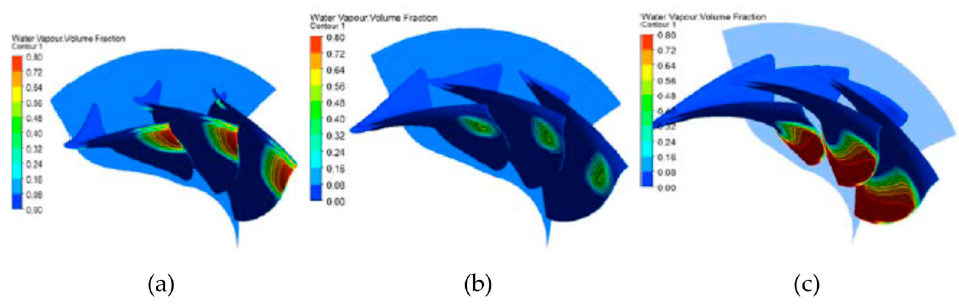
Figure 10. Contours of water vapor volume fraction at ( a ) –15 degree, ( b ) –30 degree, and ( c ) –45 degree stacking design conditions [13].